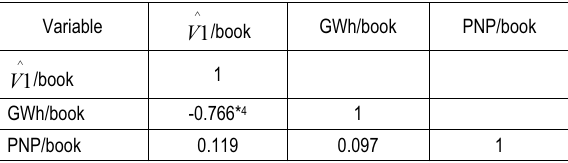
Table 7. Correlation matrix (Pearson’s correlation) of the independent variables (equation (10))